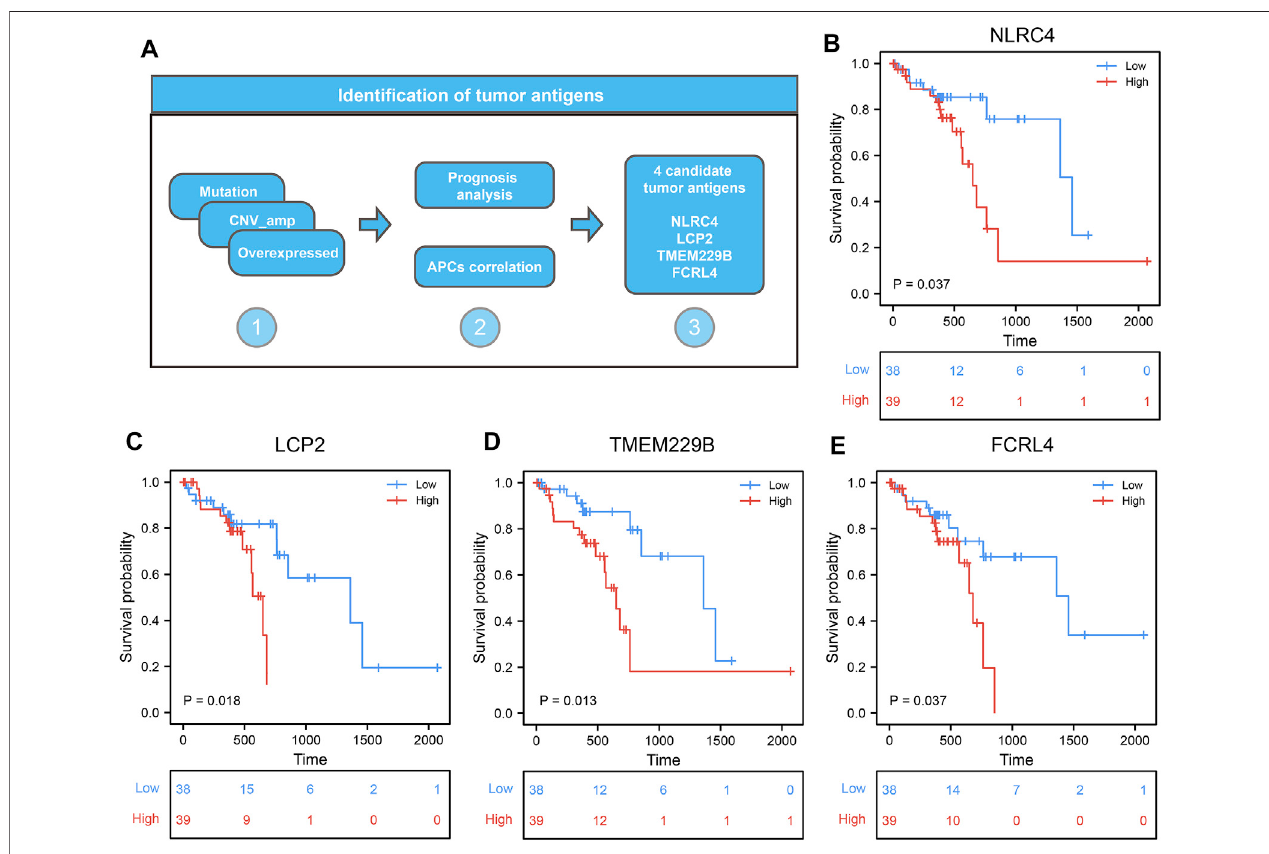
FIGURE3| Identi fi cationofcandidatetumorantigensassociatedwithESCCprognosis. (A) TheprocessionofidentifyingcandidatetumorantigensinESCC. (B – E) Kaplan – Meier curves comparing the groups with different NLRC5 (B) , LCP2 (C) , TMEM229B (D) , and FCRL4 (E) in ESCC.